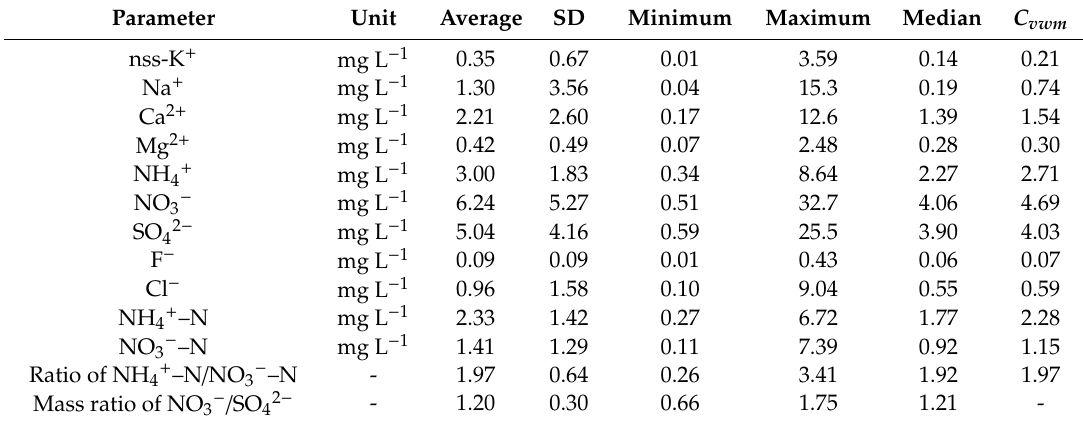
Table 1. The statistical summary of water-soluble ions in precipitation and their volume-weighted mean (VWM) concentrations from July 2019 to June 2020. nss = Non-sea salt. Parameter Na +